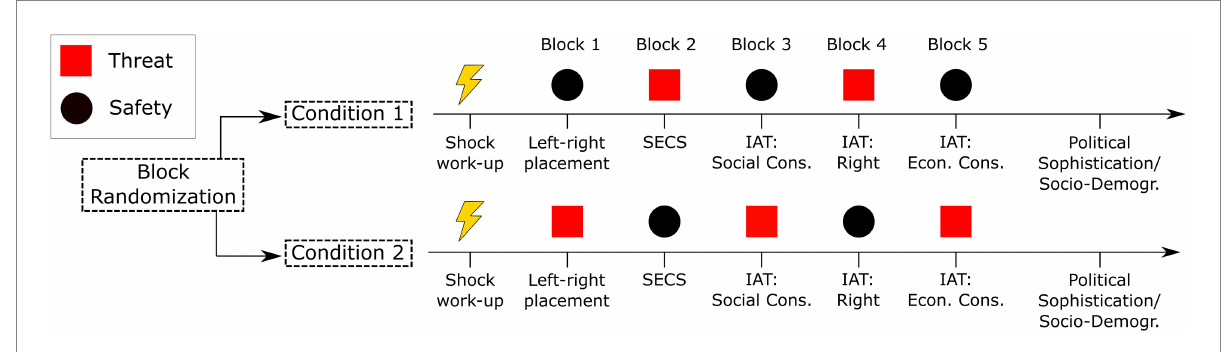
FIGURE 1 Experimental design. SECS, Social and Economic Conservatism Scale; IAT, Single-Target Implicit Association Task.